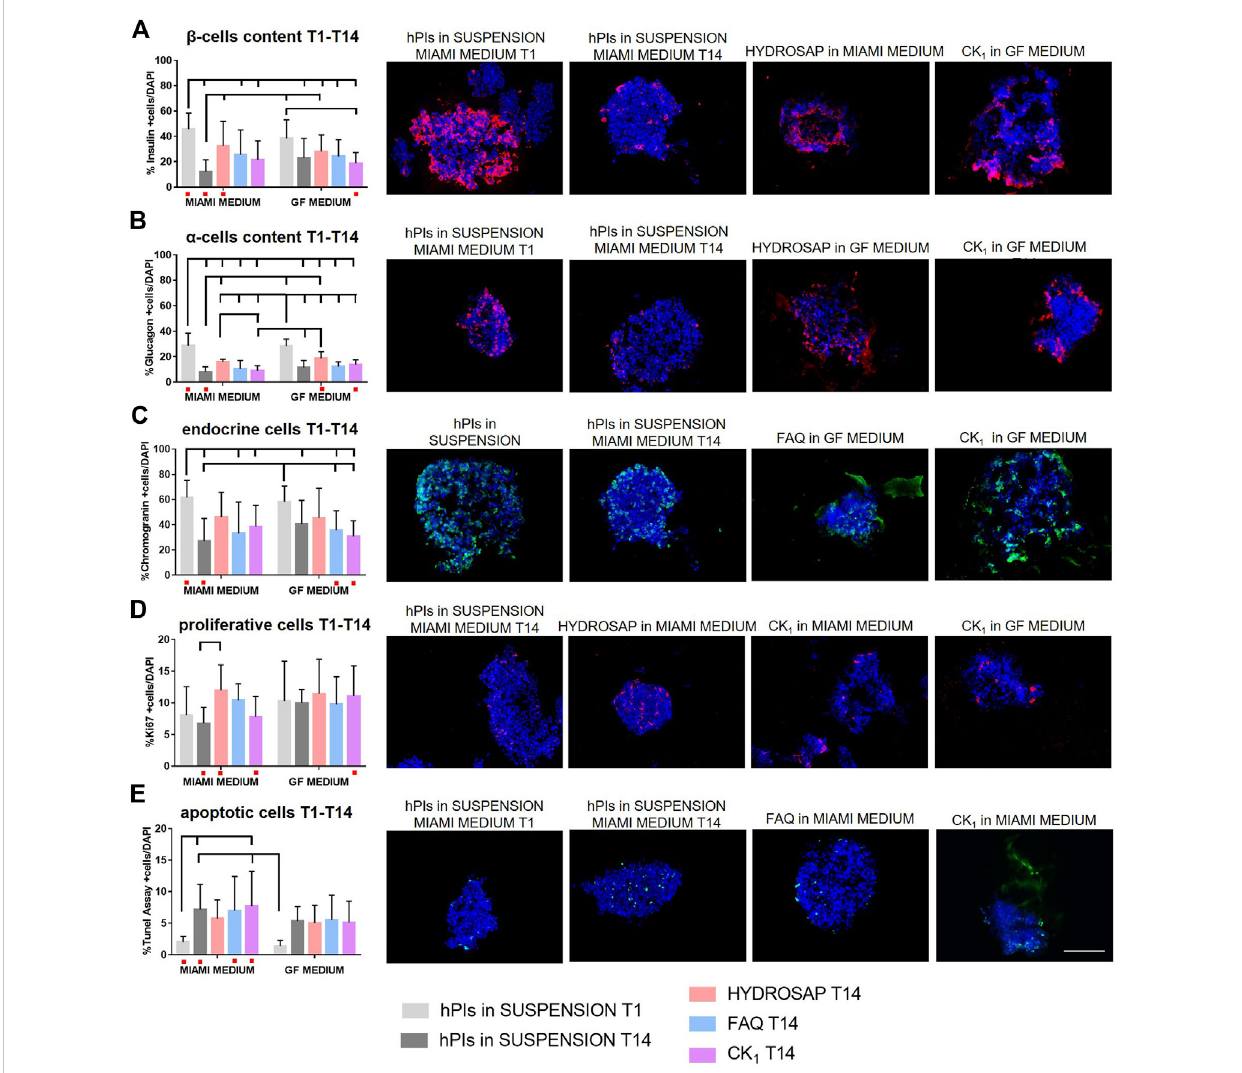
FIGURE 2 Cellular components characterization of hPIs cultured for 14-days in HYDROSAP, FAQ and CK 1 scaffolds, or plated in suspension in MIAMI medium or GF medium. Freshly-isolated hPIs in suspension cultured in MIAMI medium for 1 day (T1) were considered as positive control; conversely, hPIs maintained in suspension for 14-days in MIAMI or GF media were chosen as negative controls. Immuno fl uorescence analysis and related representative images for (A) β -cells producing insulin in red, (B) α -cells producing glucagon in red, (C) endocrine component in green, (D) cells in proliferation in red, and (E) apoptotic cells in green show the preservation for 14-days of β -cells content, endocrine cells, and proliferative component and a controlled percentage of apoptotic cells in scaffold-embedded hPIs, especially for HYDROSAP. No signi fi cant difference was highlighted between two culture media. Cell nuclei are stained in blue. Images illustrate islets in selected culture conditions, depicted in each graph with a red dot. Data are presented as mean ± SD, two-way ANOVA with Tukey post-hoc test: statistical differences were evaluated among all groups and speci fi ed in Supplementary Table S2 ( n = 3; * p < 0.05 ; ** p < 0.01 ; *** p < 0.001 ). Scale bar, 100